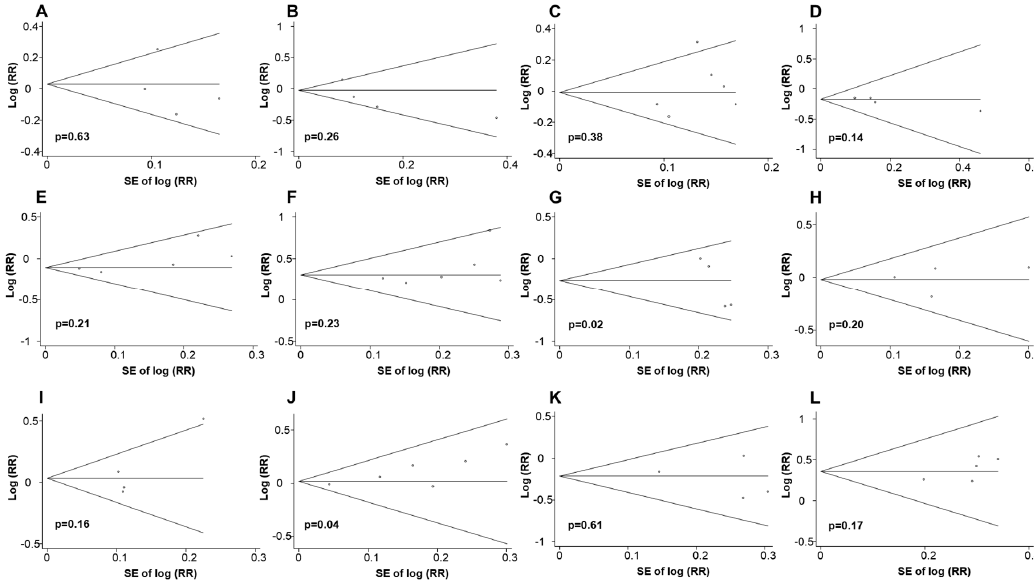
Figure 2. Funnel plot for the analysis of publication bias. ( A ) Red and processed meat, ( B ) total dairy, ( C ) alcohol, ( D ) calcium, ( E ) prudent pattern, ( F ) unhealthy pattern in association with all-cause mortality, ( G ) whole grain, ( H ) red and processed meat, ( I ) red meat, ( J ) alcohol, ( K ) prudent, ( L ) unhealthy in association with colorectal cancer death. RR, relative risk; SE, standard error.